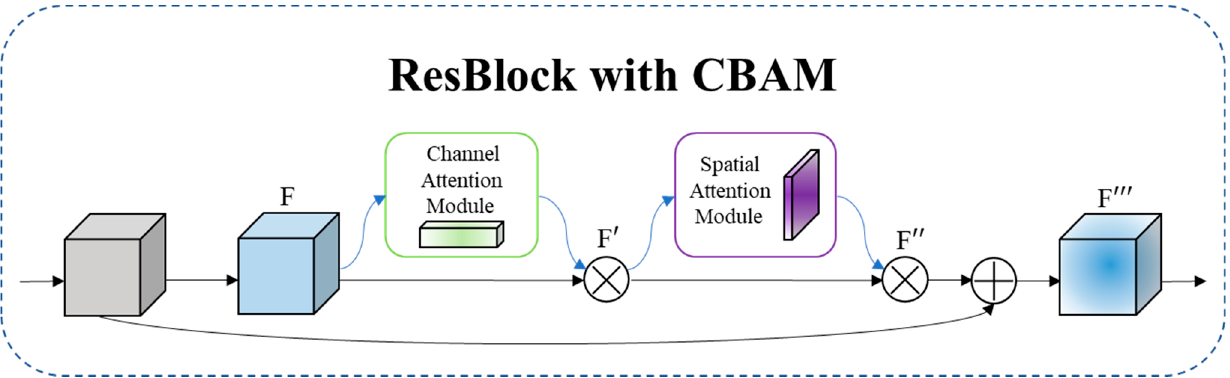
Figure 5. The overview of CBAM. The module has two sequential sub-modules: channel and spatial. The intermediate feature map is adaptively refined through CBAM at every ResBlock of DLA34.